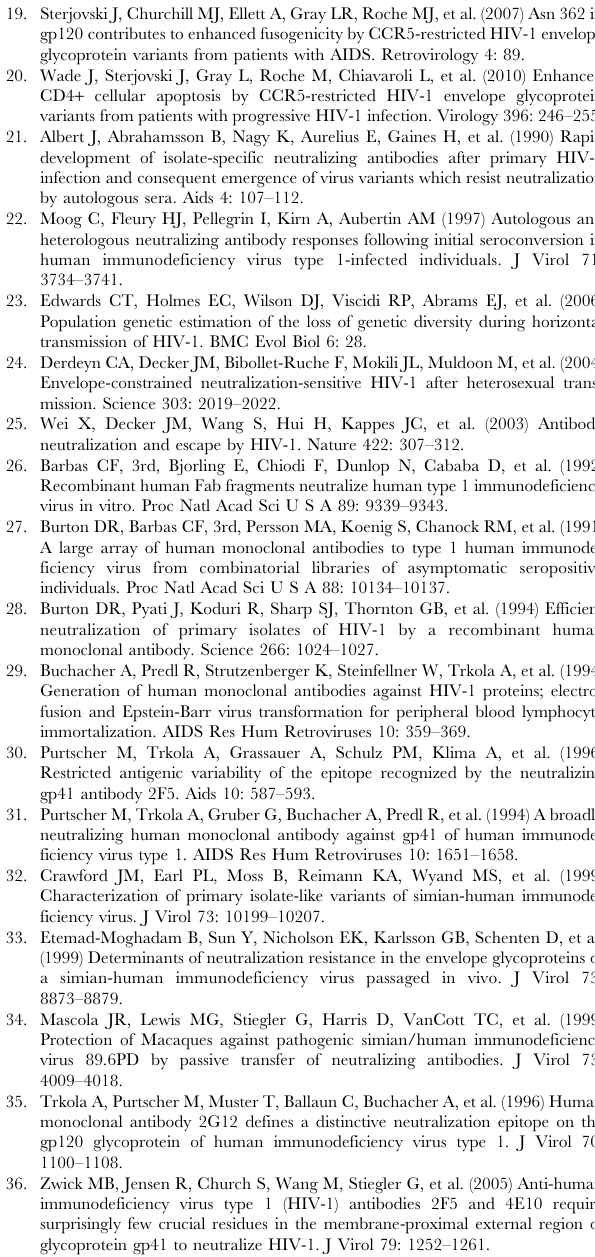
surface potential of molecular models of trimeric gp120 from chronic and end-stage R5 virus of patient G. Positively and negatively charged parts are shown in blue and red, respectively. The gp120 trimer is presented from the side with the V3 region pointing downward toward the target cell, and the approximate location of the 2G12 core epitope is depicted with arrows. Table S1 2G12 epitope in sequential R5 Env sequences and 2G12 IC50 for corresponding R5